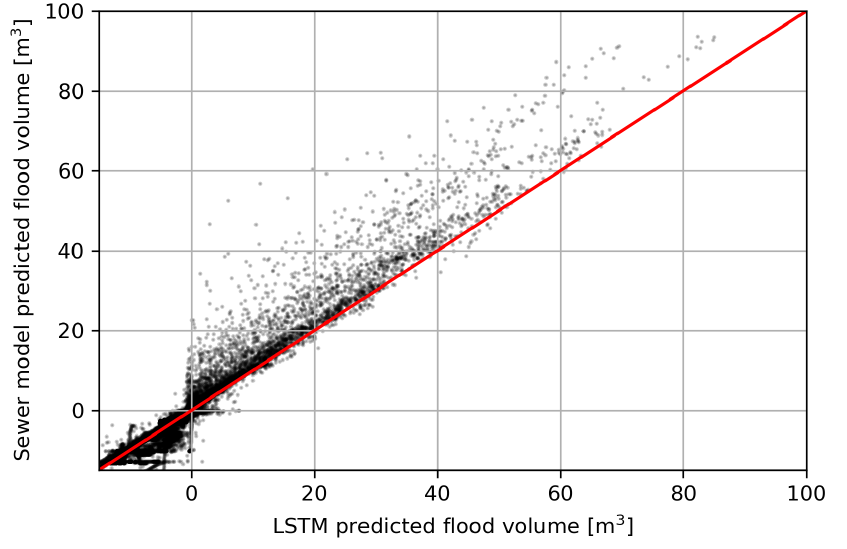
Figure 13. Scatter plot of the predicted and actual flood volumes for the LSTM regressor evaluated on the historic precipitation data set ( R 2 = 0.99). Negative flood volume are plotted until − 15 m 3 , no more false negative or false positive values are observed past this